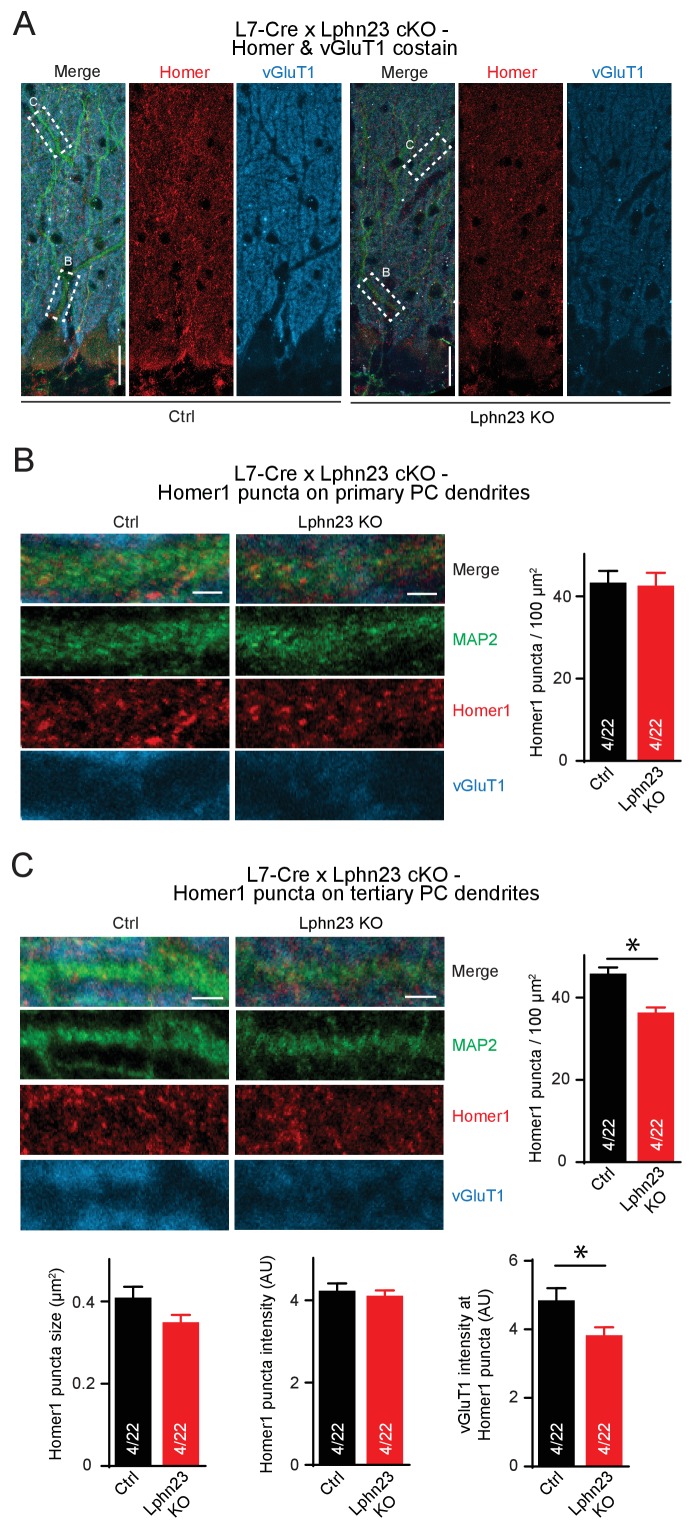
Double deletion of Lphn2 and Lphn3 from Purkinje cells decreases Homer1 puncta on distal tertiary but not primary Purkinje cell dendrites.(A–C) Deletion of both Lphn2 and Lphn3 from Purkinje cells does not affect Homer1 puncta density on primary Purkinje cell dendrites but reduces Homer1 puncta density on tertiary dendrites from the distal half of the cerebellar cortex. Climbing-fiber inputs synapses onto primary Purkinje cell dendrites while parallel-fiber inputs synapse onto tertiary dendrites. (A), representative images of Homer1 (red) co-stained with vGluT1 (blue) and MAP2 (green). (B) Homer1 puncta density on primary Purkinje cell dendrites is unchanged (left: representative images; right: summary graph). (C) Homer1 puncta density and vGluT1 staining intensity at Homer1 puncta is reduced by Lphn2/3 double-deletion at tertiary Purkinje cell dendrites but Homer1 puncta size and staining intensity is unchanged (top left: representative images; top right and bottom: summary graphs).Scale bars are 20 µm in A and 2 µm in B-C. Data are means ± SEM; numbers in bars represent independent experiments/number of cells tested. *p<0.05 (two-tailed t test).